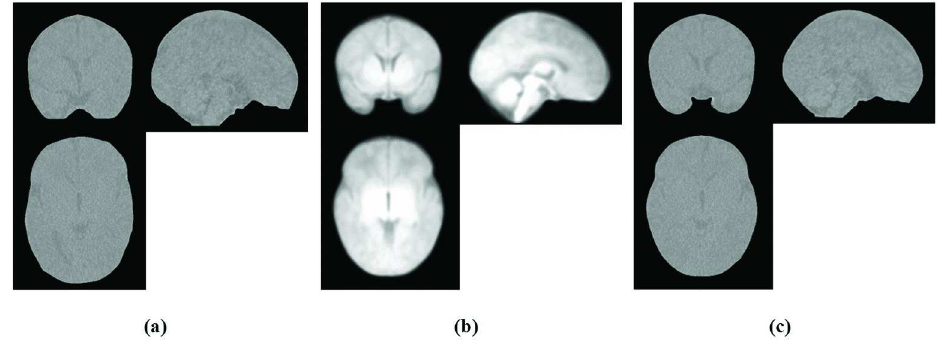
registeredto GRAMFC_T 39-42 intracranial space using affine and non-linearSyN approach[54].